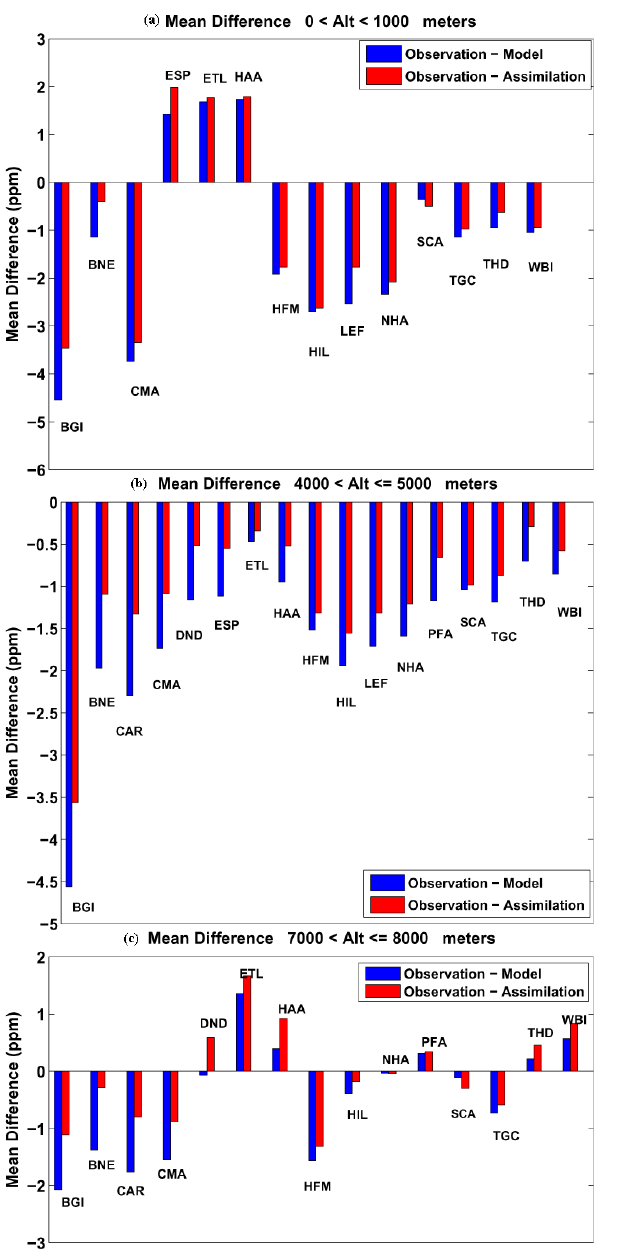
Fig. 8. Mean difference (Observation − Analysis) between the NOAA/ESRL aircraft data and CO 2 from the GEOS-5 model (or